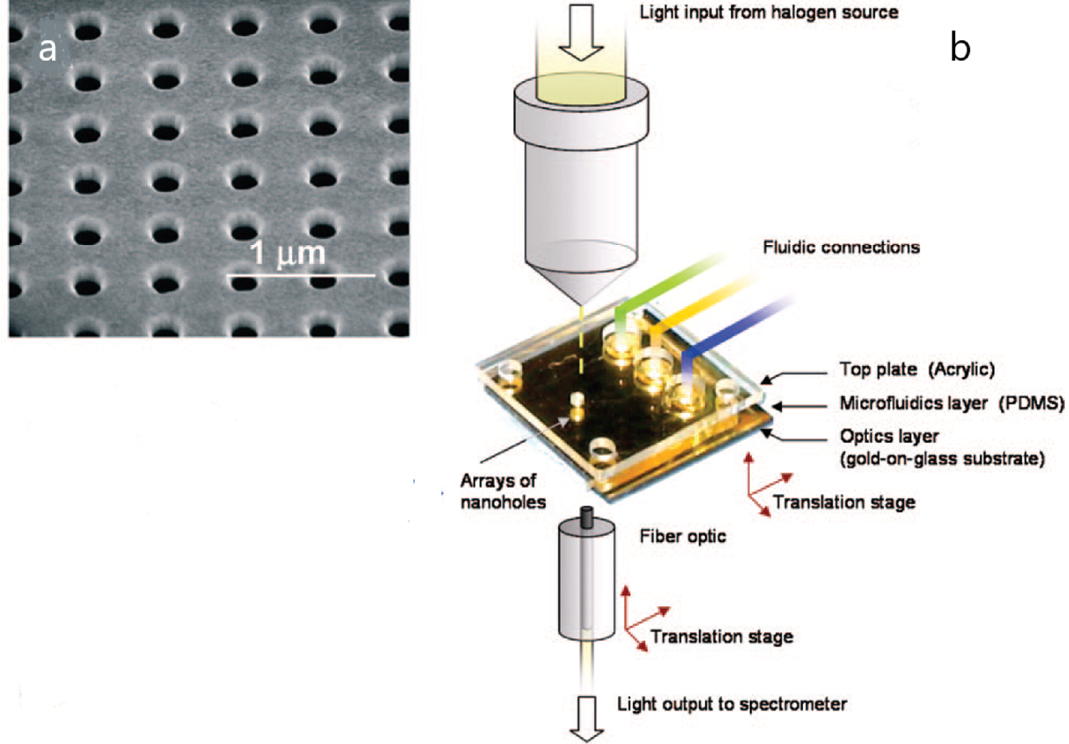
Figure 3. ( a ) Scanning electron microscopy (SEM) image of an array of nanoholes in a gold film; ( b ) experimental setup of a plasmonic-based nanohole array biosensor. Adapted with permission from Gordon et al. [29] (Copyright © (2008) American Chemical Society).